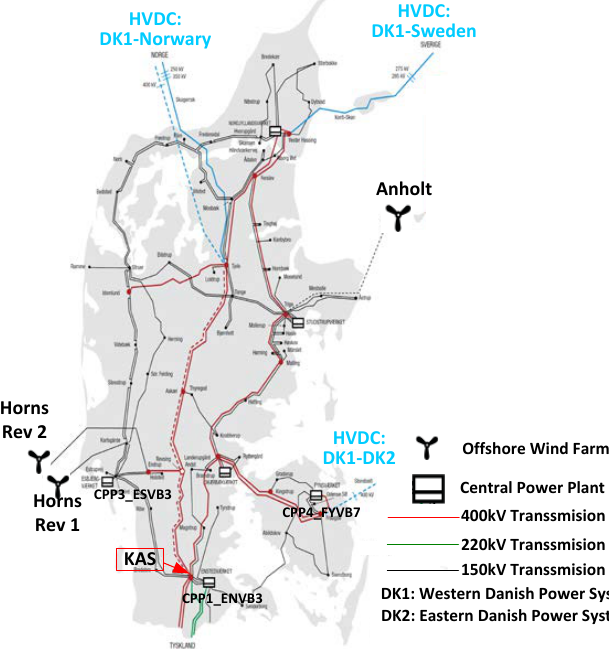
Figure 7. Geographical map of the western Danish power system [25].